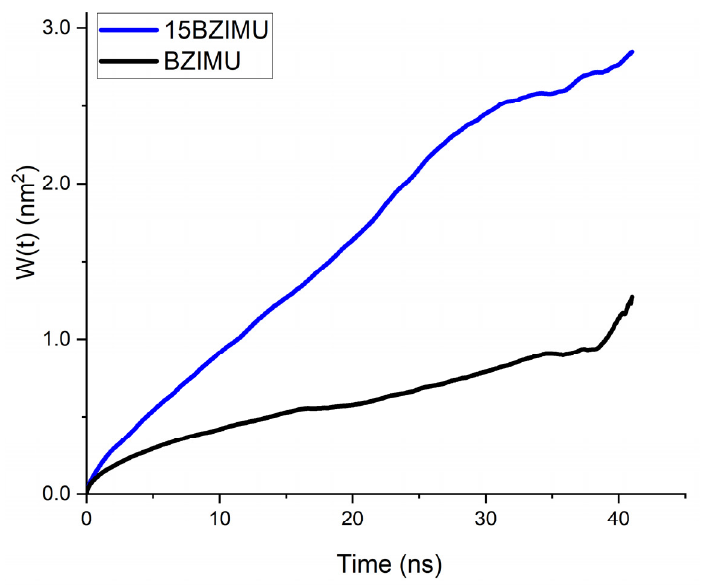
Figure 7. Simulated MSD for a single molecule of BZIMU and the BZIMU cluster of 15 molecules.